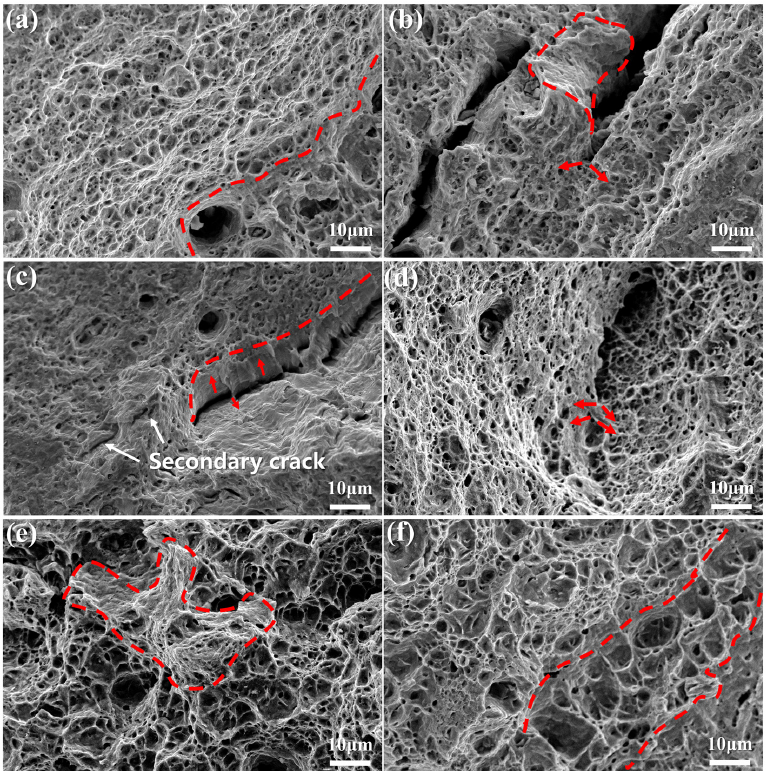
Figure 11. The tensile fiber zone fracture of the thermal simulation specimens at T max = 1250 °C under different t 8/5 values: ( a ) t 8/5 = 4 s, ( b ) t 8/5 = 6 s, ( c ) t 8/5 = 8 s, ( d ) t 8/5 = 10 s, ( e ) t 8/5 = 14 s, and ( f ) t 8/5 = 18 s.